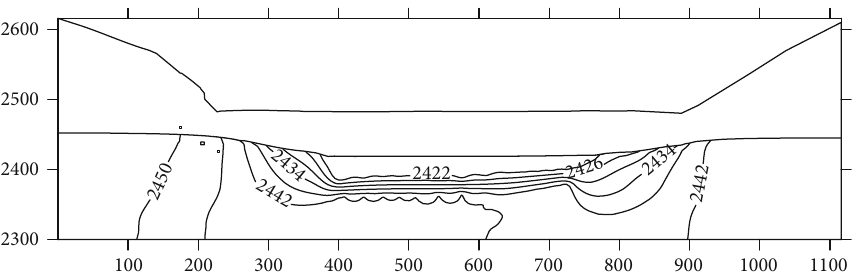
Figure 8: The isopotential distribution map of seepage fi eld about dam foundation (2-2pro fi le).